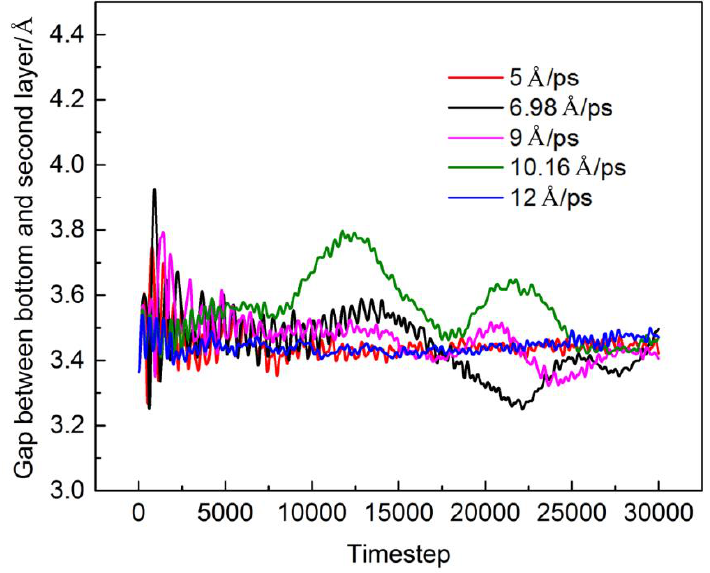
Figure 8. Variation of distance between the second and bottom layers of graphene versus timestep.